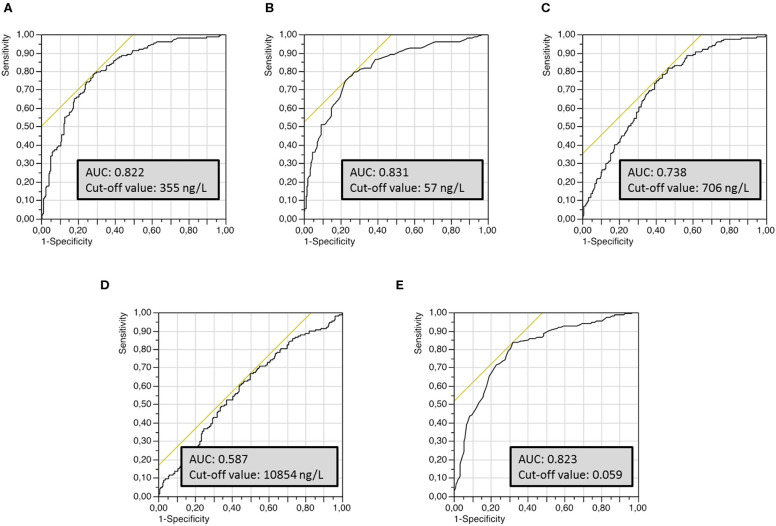
Univariate receiver operating characteristics (ROC) curves of the different CSF biomarkers used to establish optimal cut-off values for the discrimination of AD from non-AD groups. (A) T-Tau protein, (B) P-Tau181 protein, (C) Aβ42 peptide, (D) Aβ40 peptide, (E) Aβ42/Aβ40 ratio.